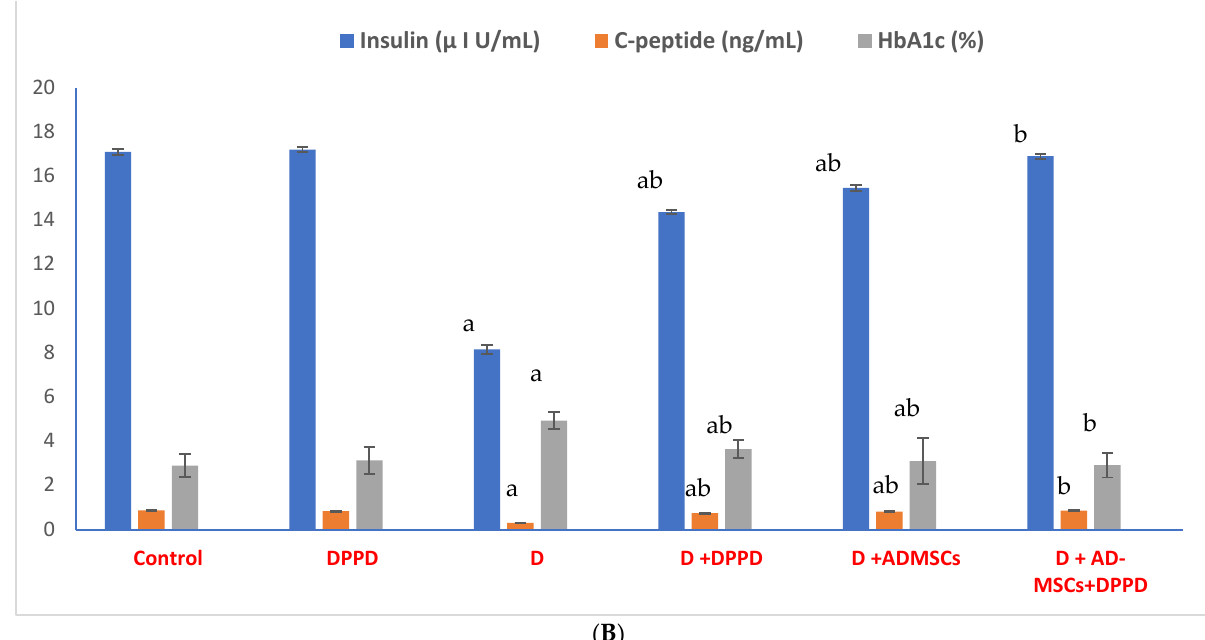
Figure 3. ( A ) Serum glucose levels (mg/100 mL). Values expressed as ± SEM ( n = 6). a, b are Significant differences ( p ≤ 0.05) compared to control, diabetic untreated and DPPD-diabetic treated groups, respectively. % is the percent of change compared to the diabetic group. ( B ) Serum insulin, C-peptide, and HbA1c levels. Values expressed as ± SEM ( n = 6). a, b are Significant differences ( p ≤ 0.05) compared to control, diabetic untreated and DPPD-diabetic treated groups, respectively. % is the percent of change compared to the diabetic group.